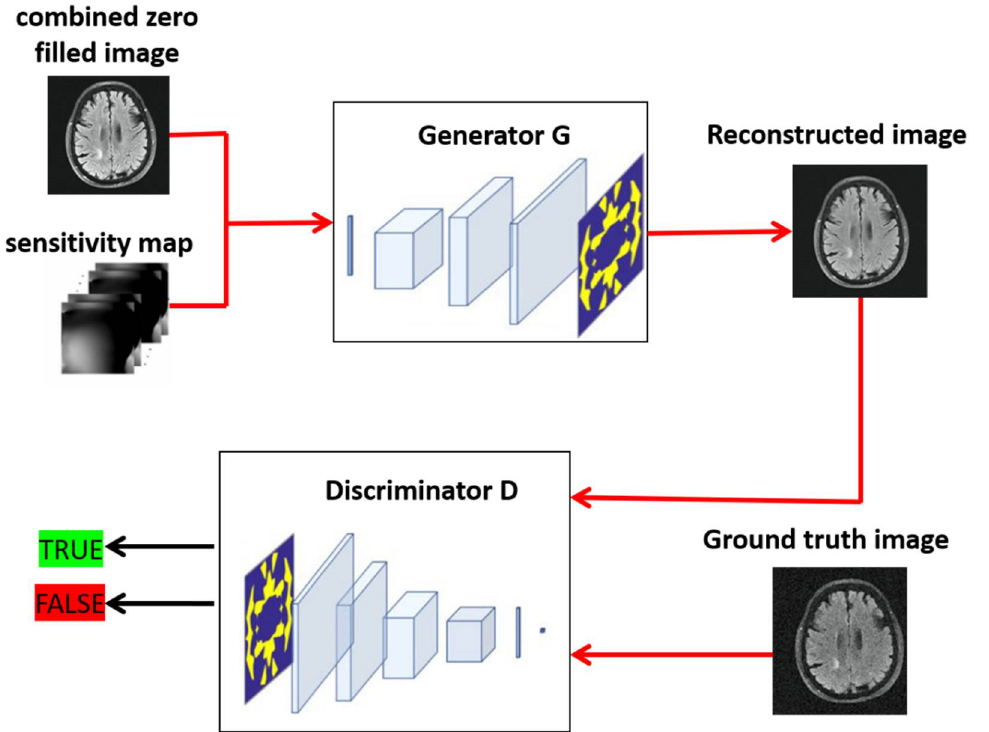
Figure 2. Our proposed GAN architecture, including a generator and discriminator. The generator G takes the input ZF and sensitivity map. The details of both generator G and discriminator D are discussed and shown below in Figures 3 and 4.